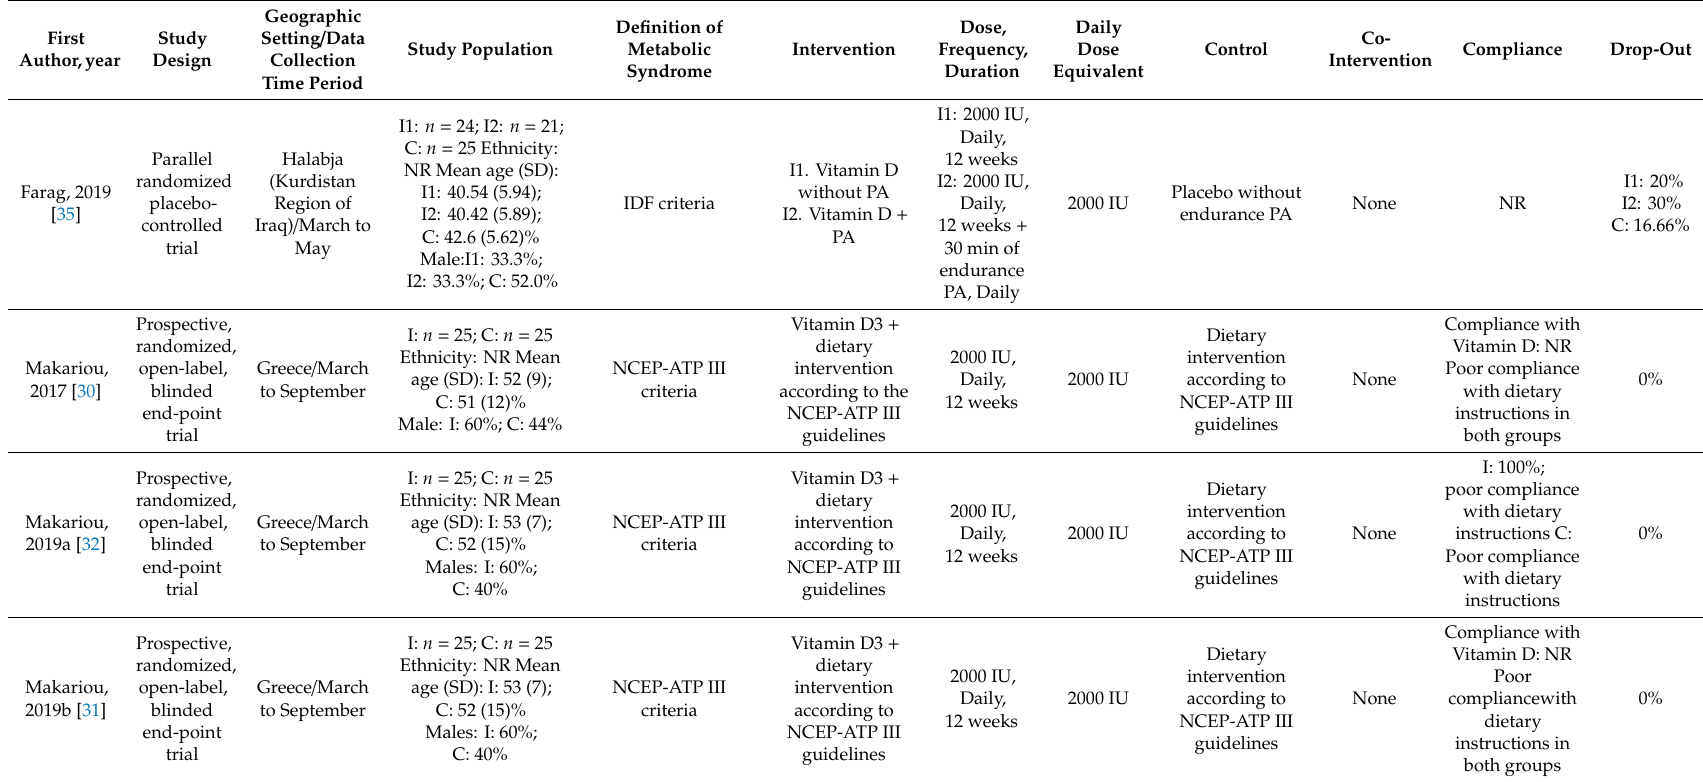
Table 1. Characteristics of included